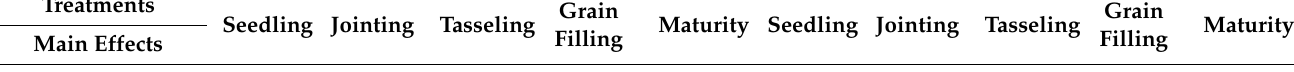
Table 1. Interactive impact of straw mulch and biochar application rates on the plant height of the maize